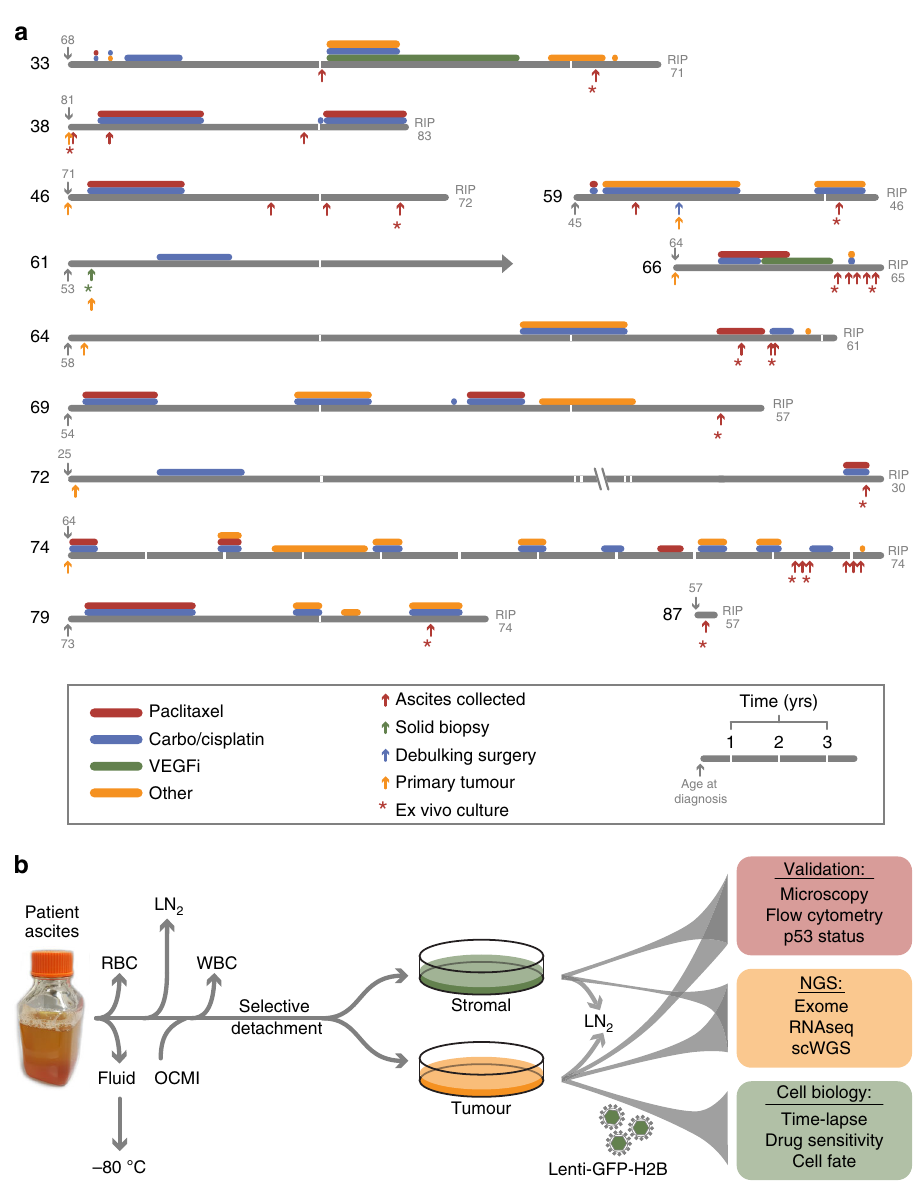
Fig. 1 Establishing a biobank of ovarian cancer ex vivo models. a Patient timelines showing age at diagnosis and death, treatments and biopsy collections. b Work fl ow for processing and storage of stromal and tumour fractions. (RBC red blood cells, WBC white blood cells, LN 2 and − 80 ° C speci fi es long-term storage, OCMI ovarian carcinoma modi fi ed Ince medium, NGS next-generation sequencing, VEGFi vascular endothelial growth factor inhibitor). See also Supplementary Fig. 1 and Supplementary Tables 1 and